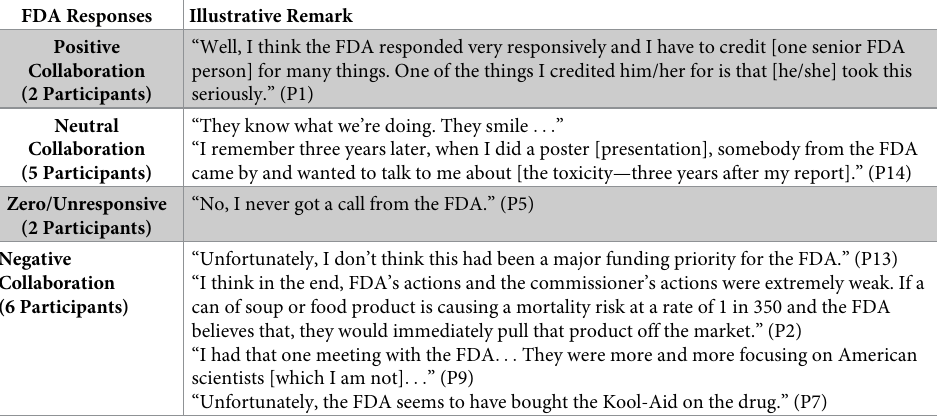
Table 5. Interviewee report of fda employee